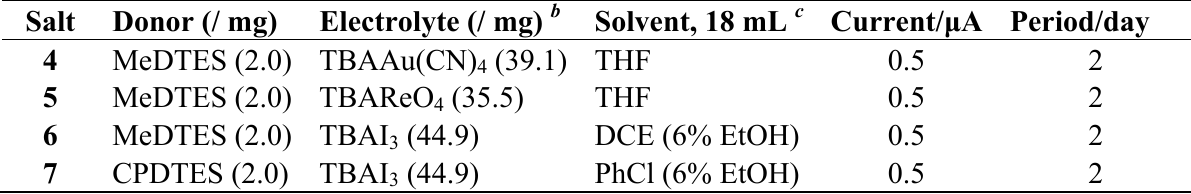
Table 2. Conditions of the preparation of 4 − 7 a .